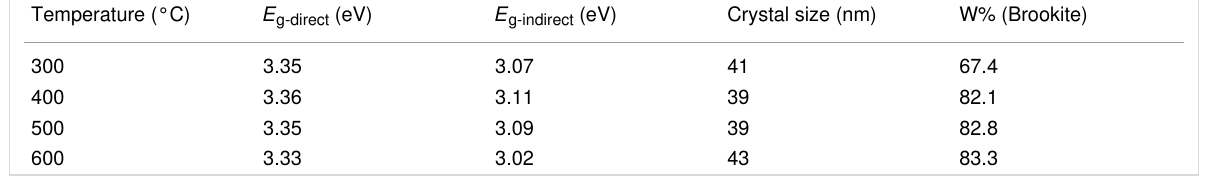
Table 1: Listed are the direct/indirect bandgaps determined from diffuse reflectance spectra, the crystal size determined from the (211) diffraction peak, and the weight percentage of the brookite phase. Temperature (°C)